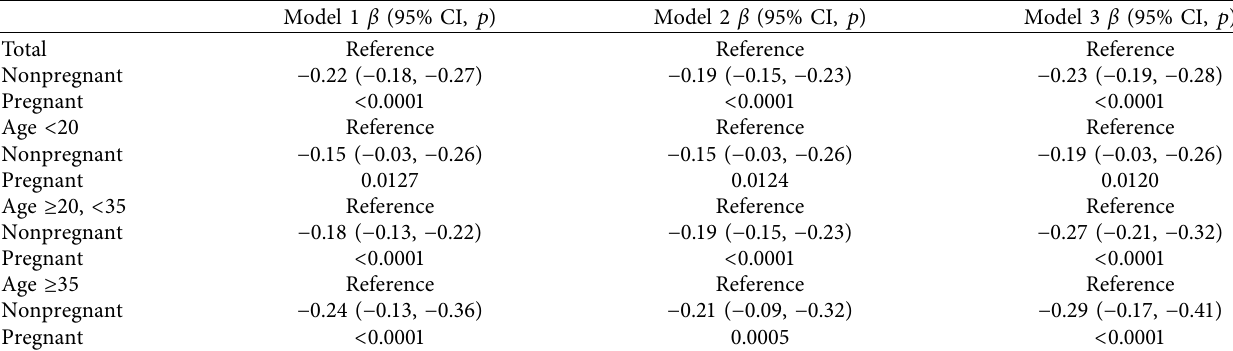
Table 4: Associations between self-reported pregnancy status and HbA1c (%) in nondiabetes women. Model 1 β (95% CI, p )